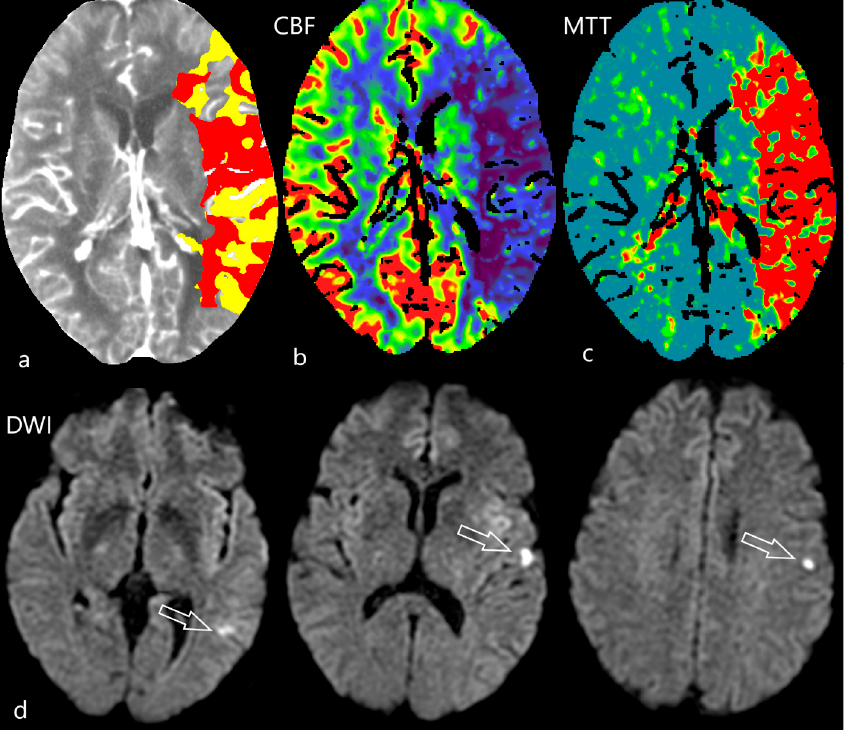
Figure 4. Ghost infarct on CTP. 68-year-old female was referred as acute stroke in the early time window 1.5 h since the last known well. She suffered from right sided hemiparesis and aphasia. CTA confirmed occlusion of the left medial cerebral artery. On CTP [upper row, ( a )] there is a map with the calculation on penumbra (yellow area) and ischemic core (red area). On the cerebral blood flow map (CBF) a hypoperfusion of the whole region of the left medial cerebral artery was seen [( b ), blue area], mean transit time (MTT) was prolonged [( c ), red area]. Endovascular treatment was promptly indicated. The second day after endovascular mechanical thrombectomy, she was without neurological deficit and was sent to MRI follow-up [lower row, ( d )]. On diffusion weighted images (DWI) only 3 very small acute ischemic lesions were found